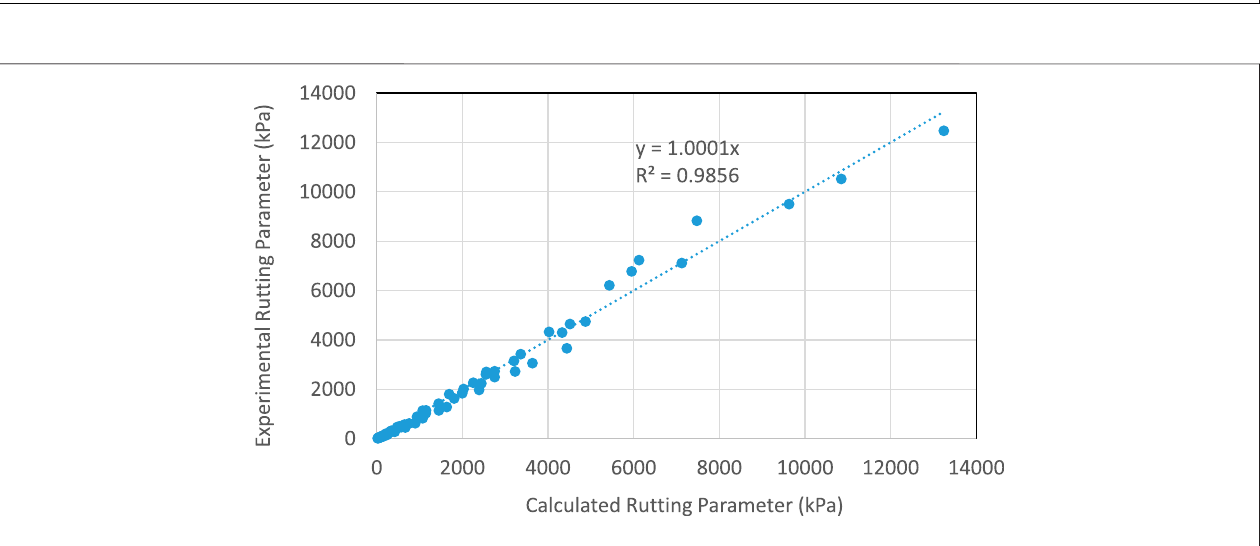
FIGURE 8 | Predicted vs. experimental rutting parameter for the unaged modi fi ed CMAs: Modeling points.